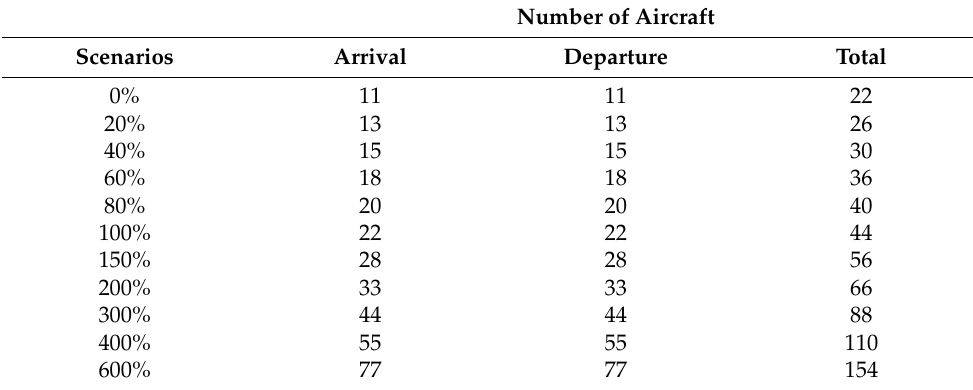
Table 8. Number of operations during the peak 3-h